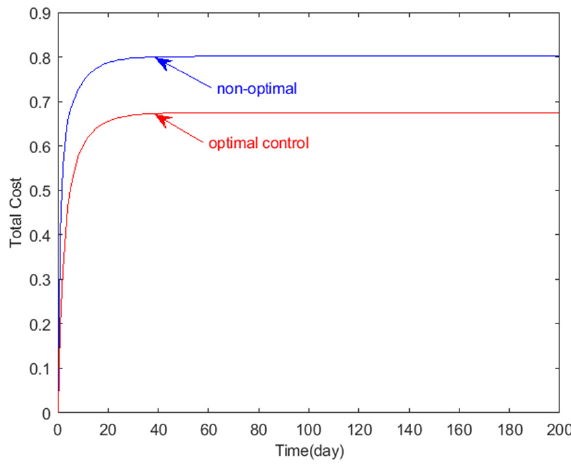
Figure 6. Total cost under optimal control and non-optimal control.